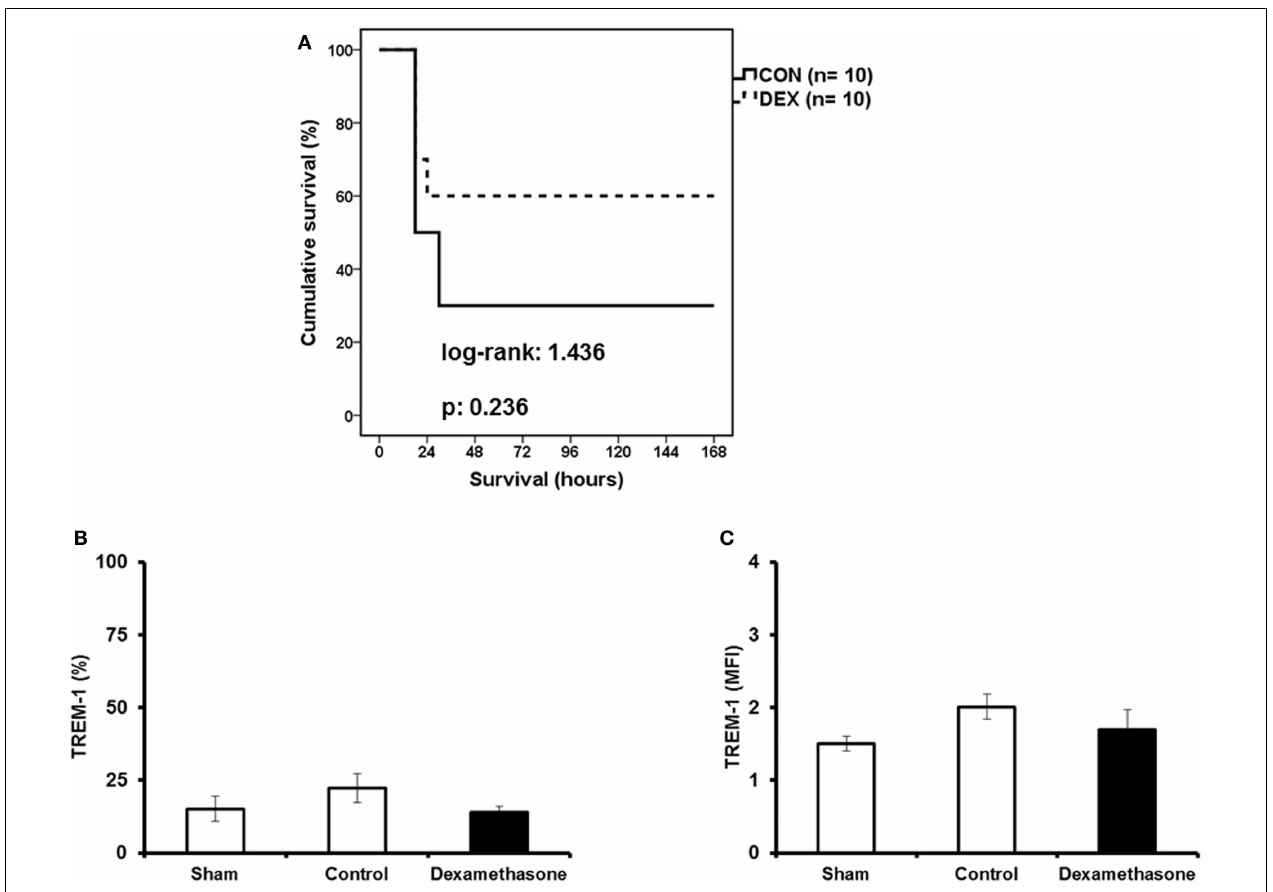
ofTREM-1 on neutrophils at sacrifice performed 6h after bacterial challenge (six mice per group) is shown. Results from sham-treated mice (Sham, no infection with P. aeruginosa ) are also provided. Data forTREM-1 are shown as percent of neutrophils expressingTREM-1 (B) or expressed asTREM-1 MFI for neutrophils (C) .